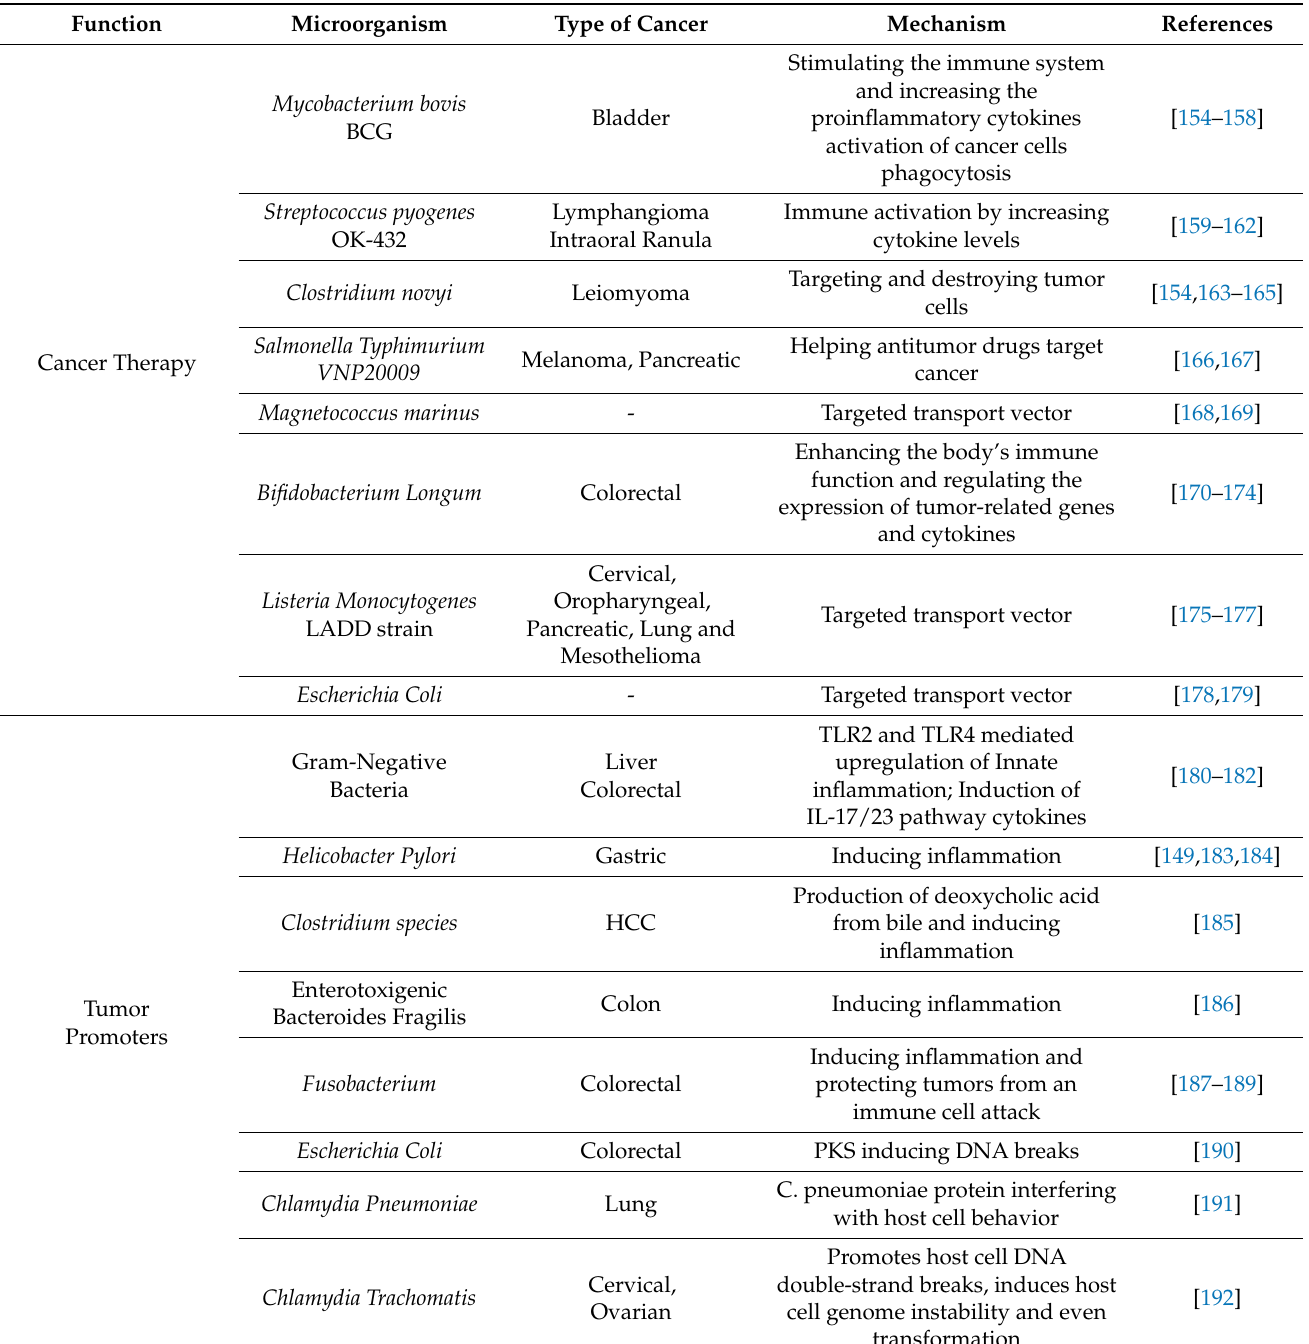
Table 3. The microbiome: cancer friend or